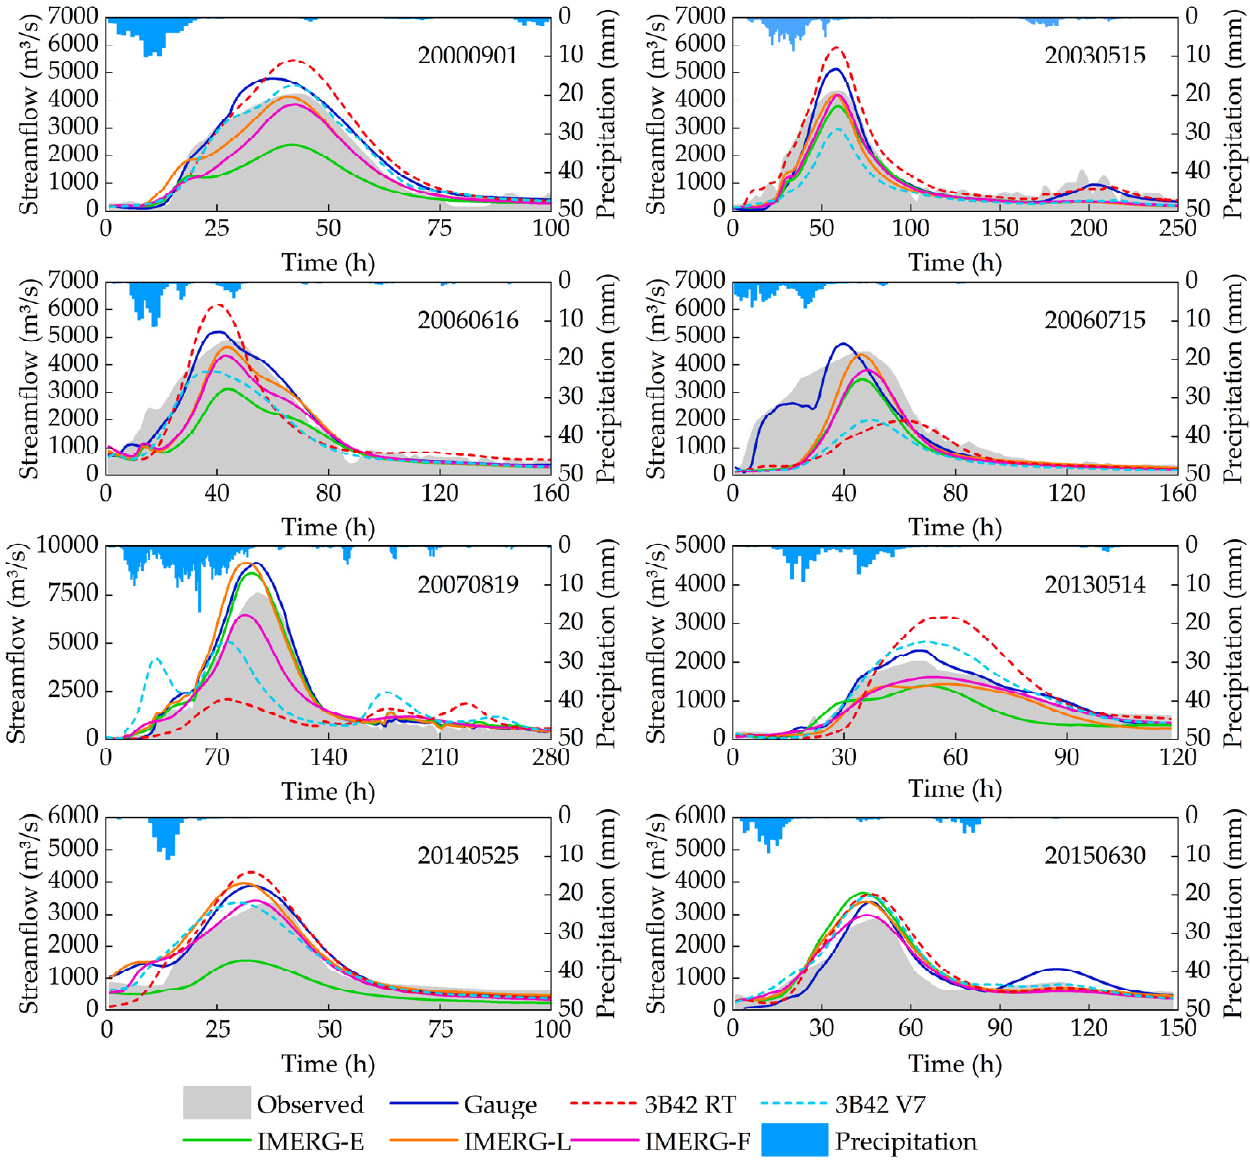
Figure 7. Comparison of the observed and simulated hourly hydrographs by gauge precipitation and the five satellite remote sensing precipitation products of the eight historical flood events in 2000–2015 at the Ganxi hydrological station.